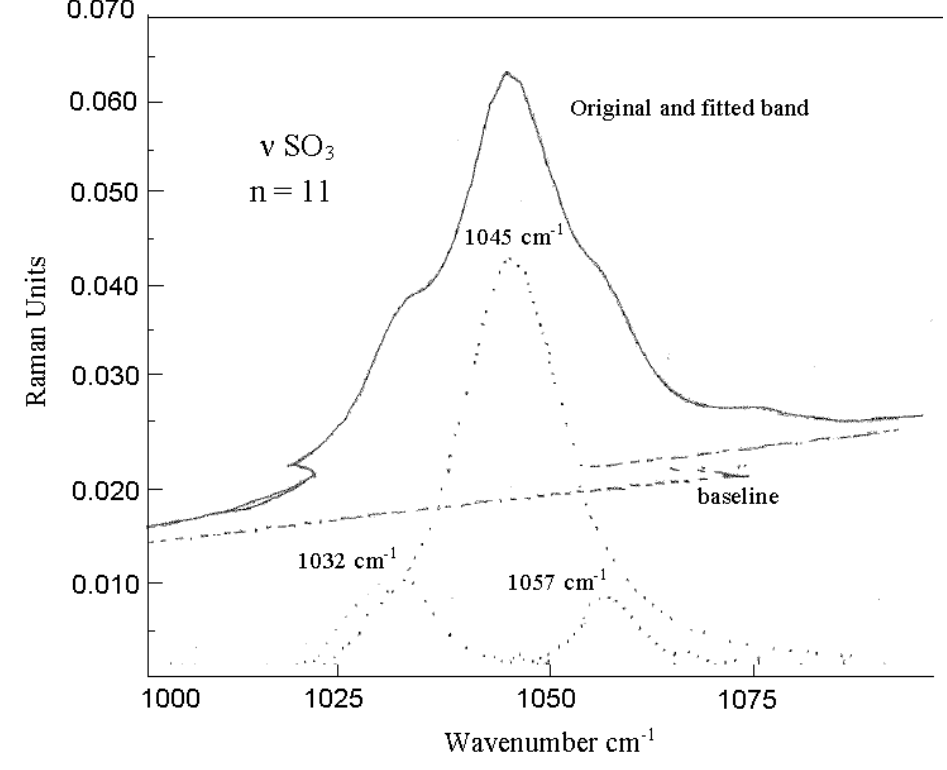
Figure 5. Band decomposition of symmetric valence vibration of SO 3−